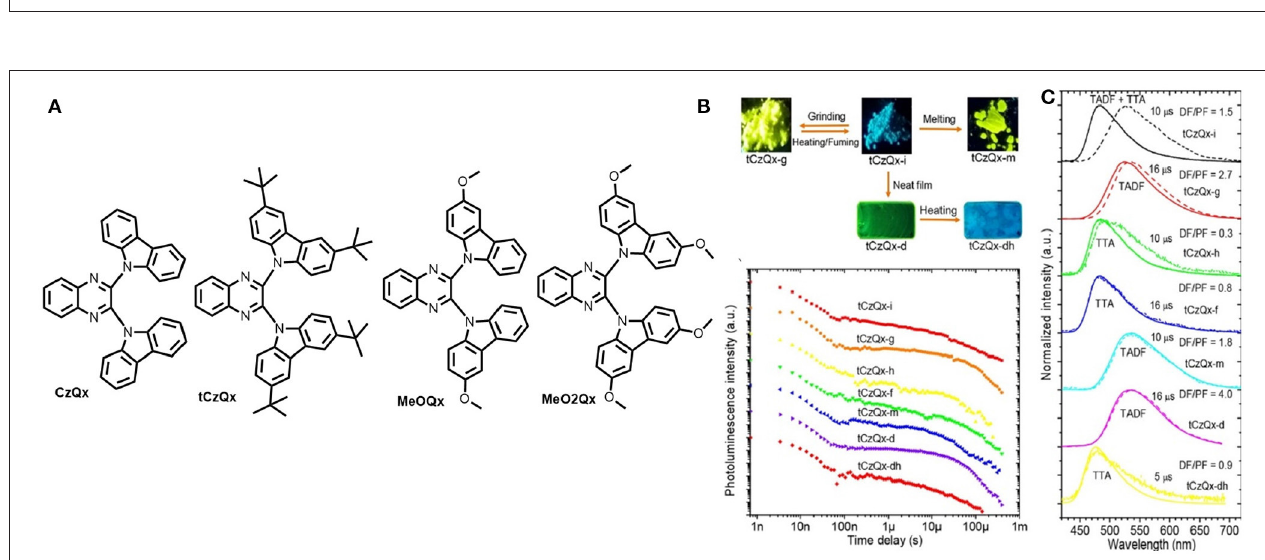
FIGURE 7 | (A) TADF chemical structure of D-A-D triads. (B) Images of tCzQx at different forms (top-left); Distinct PL-decay plots of different states of tCzQx (bottom-left). (C) Time- resolved PL- spectra of the compound (solid lines: prompt fluorescence, dashed lines: delayed fluorescence). Reproduced with permission from Pashazadeh et al. (2018b). Copyright © American Chemical